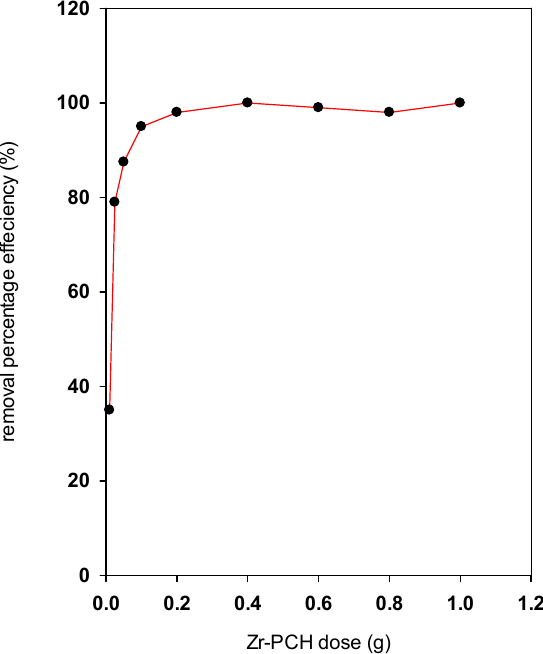
Figure 8. Effect of Zr-PCH amount (g) on the removal percentage of BB-41.